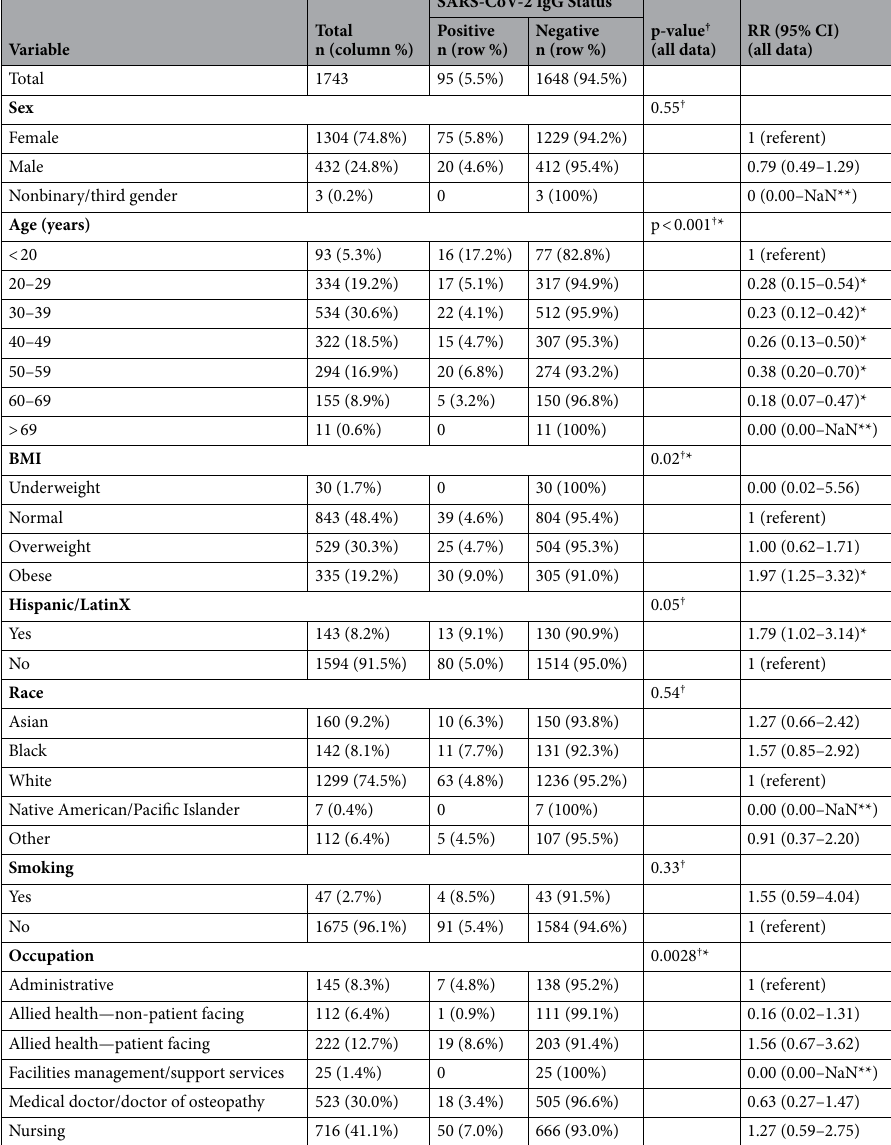
Table 1. Study demographics. † Fisher’s Exact Test, otherwise, Chi Squared. *Statistically significant when p-value < 0.05. **NaN is Not a Number, unable to divide by 0. Column percentages may not always add up to 100% due to missing data. Missing data ranged from 0.11–1.32%. Administrative: Director,